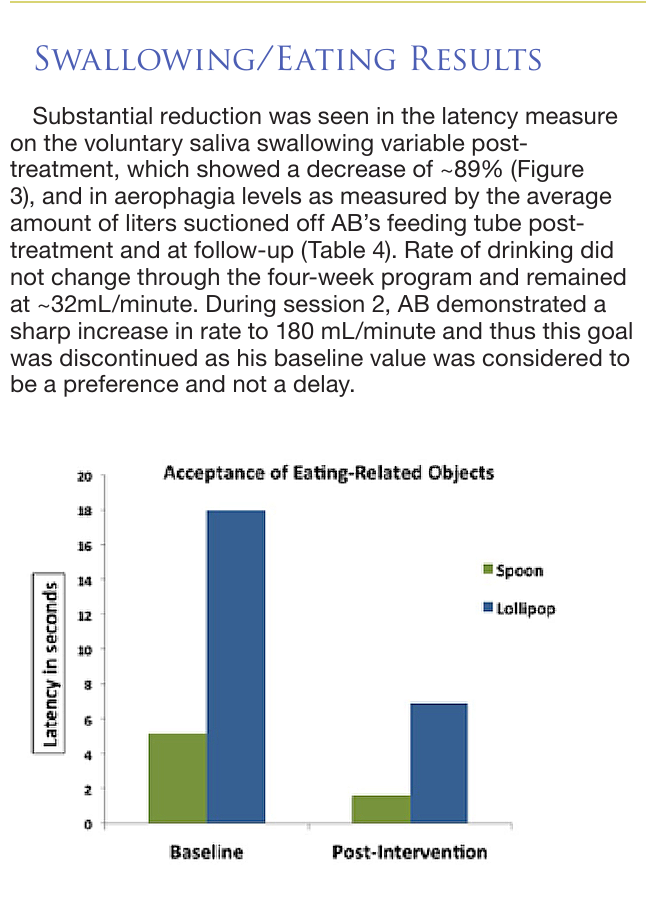
Figure 2. Latency of oral acceptance/tolerance of eating- related objects at baseline and post-intervention; results were based on one trial at each time.